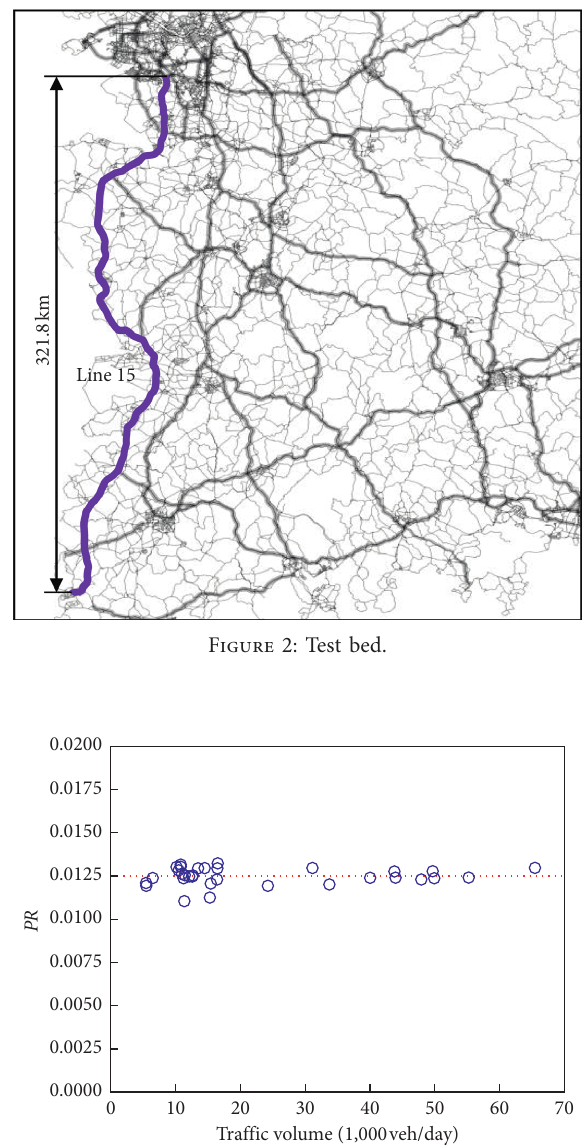
Figure 3: PR according to the traffic volume.